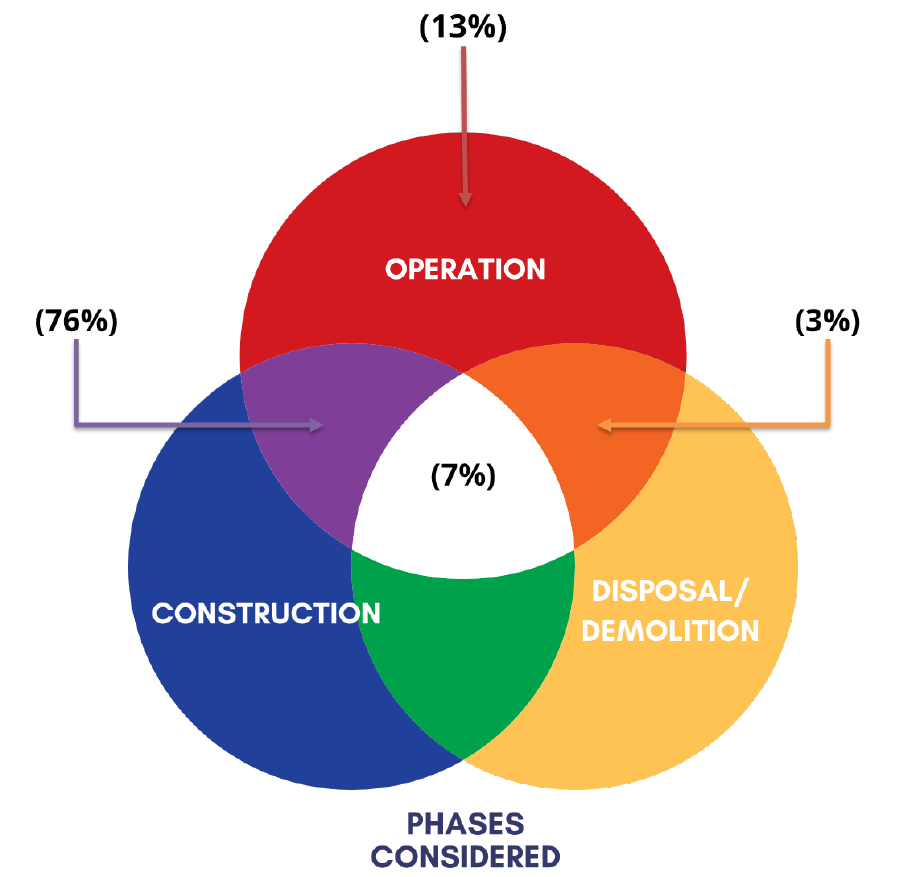
Figure 5. Phases of processes considered for the LCA.